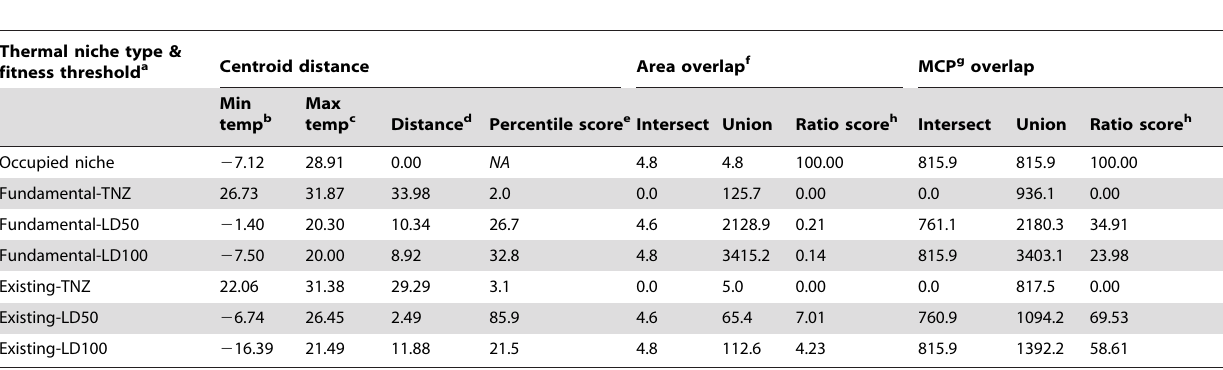
Table 3. Ability of the occupied niche to describe properties of the physiological niche, comparing across three niche property estimators (centroid, area, MCP), both fundamental and existing niches, and three fitness thresholds (TNZ, LD50, LD100).